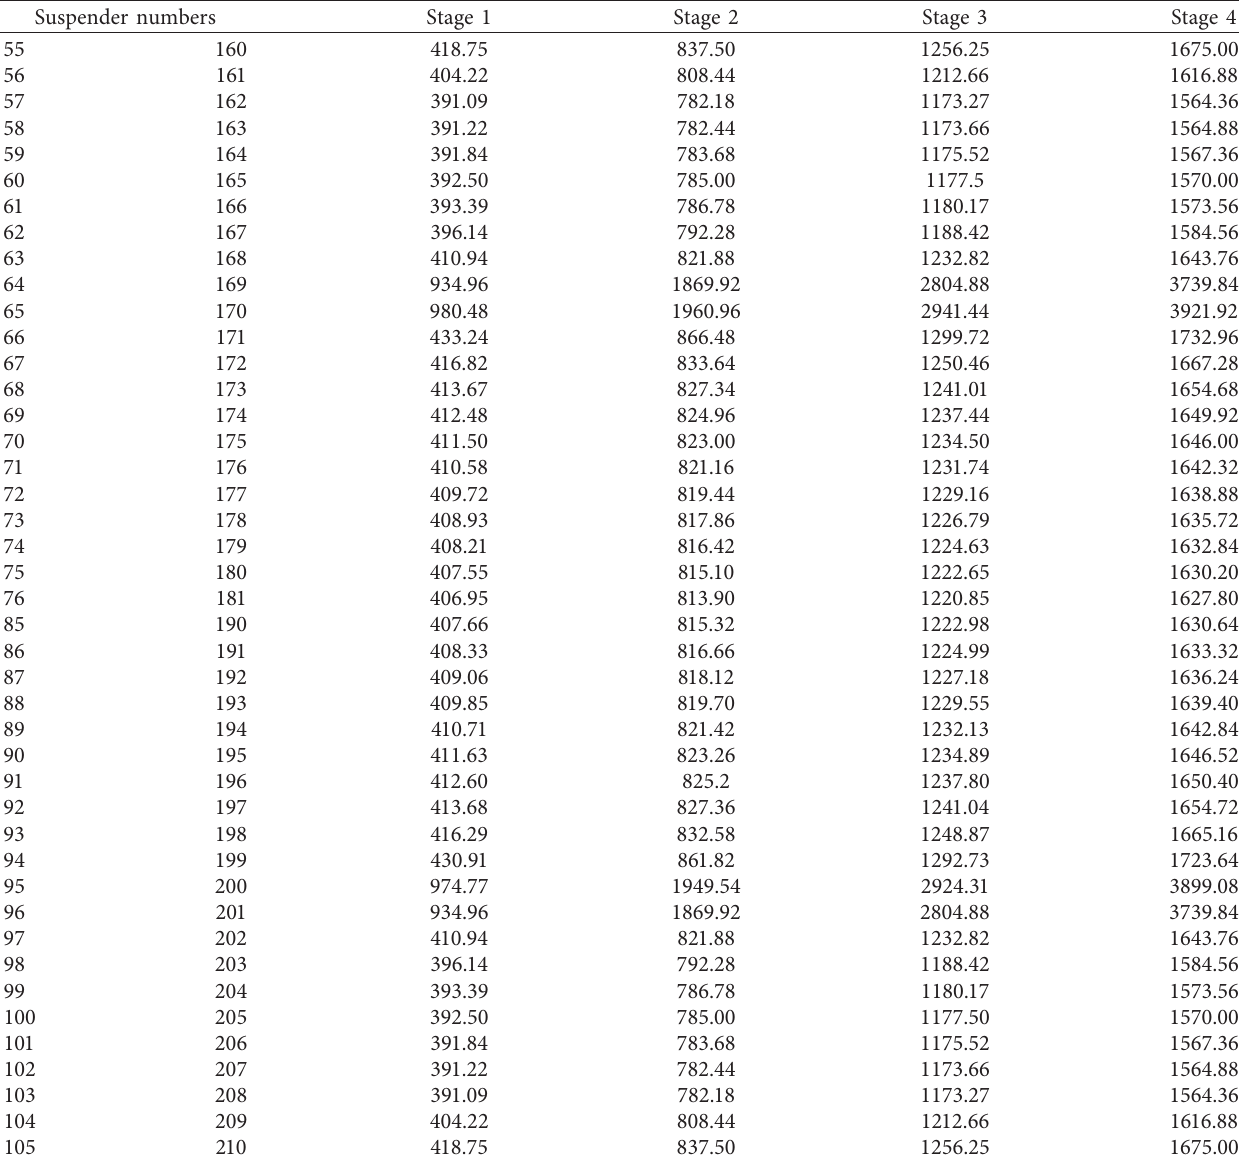
Table 2: Suspender force at each tensioning stage (unit: kN).